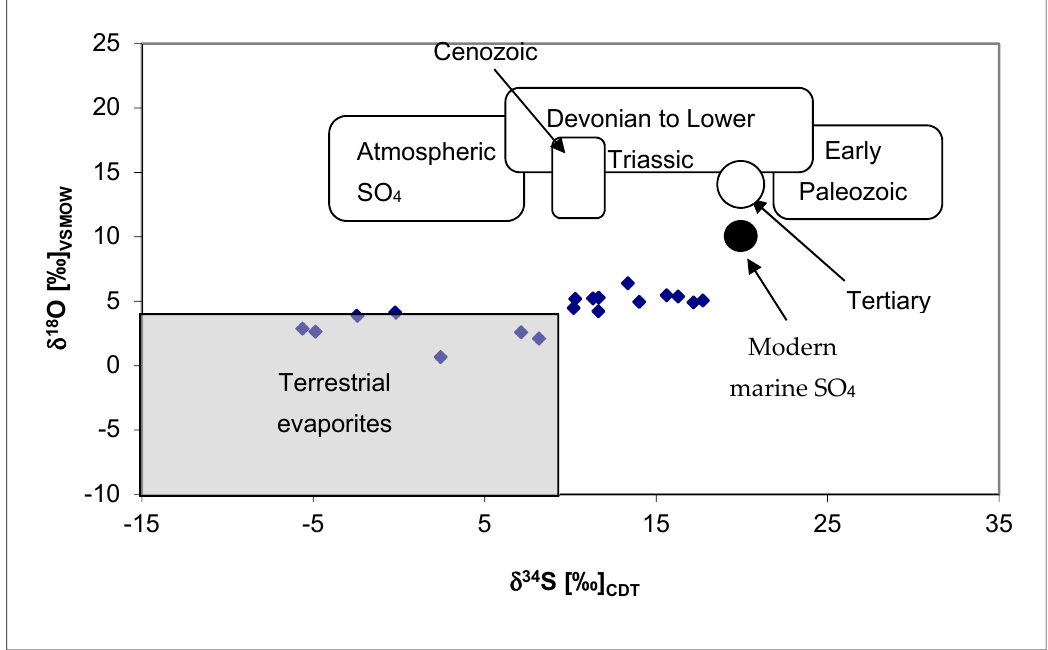
Figure 4. The isotopic composition of the dissolved sulphate in the thermal waters of Budapest and its surroundings on the δ 34 S– δ 18 O diagram in comparison with terrestrial, marine and atmospheric sulphates [17].